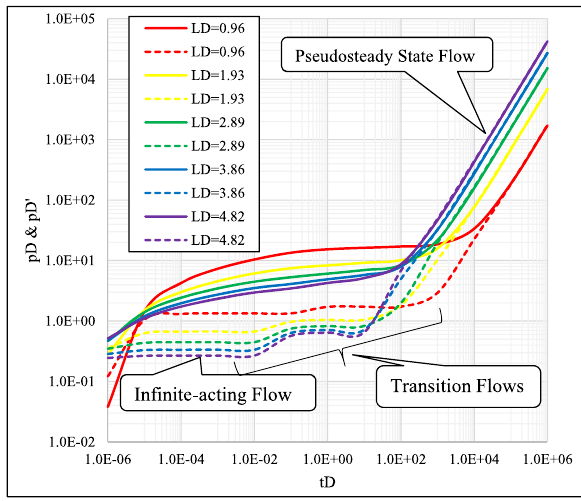
Figure A1: Variation in dimensionless pressure and dimensionless pressure derivative with L D Figure A1 shows the plot of P D and P log – log axes where the solid lines represent P D against t D , while the dashed lines represent P D ′ against Figure A1, the in fi nite - acting fl ow is identi fi ed as the fi rst fl ow period. This fl ow period starts shortly after the well